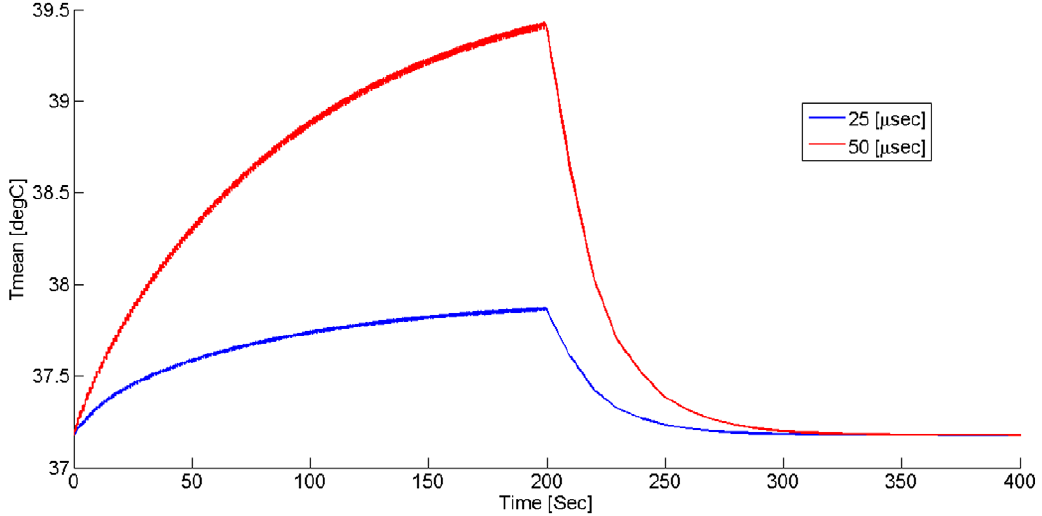
Figure 2. Normalized bleeding weight in all animal groups (rats and rabbits). Control groups were not treated. EPT50 and EPT 25 were treated by 200 pulses of 50 and 25 m s, respectively, in a repetition rate of 1 Hz. Bars represents standard error. Unpaired t-test results for various comparisons are as follows: (*) p , 0.001, (**) p=0.43, (***) p=0.025, (****) p=0.004. doi:10.1371/journal.pone.0049852.g002 PLOS ONE |